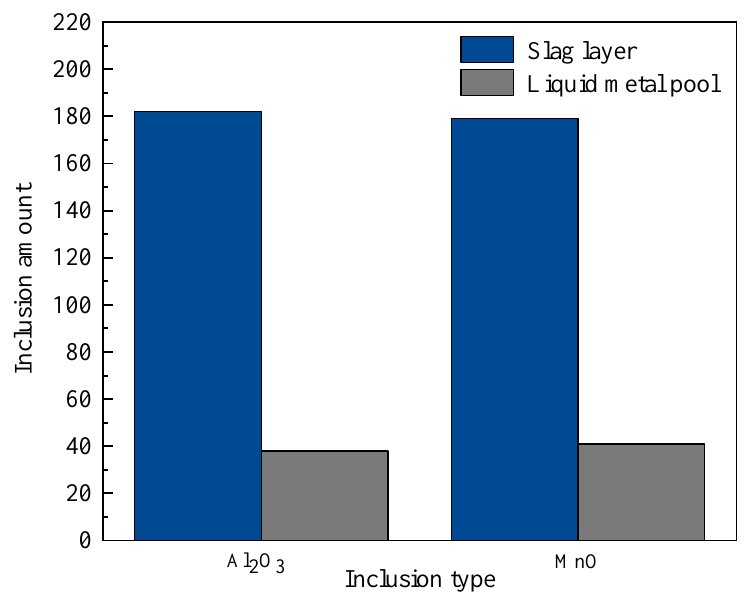
Figure 17. Comparison of removal ratio with different types.